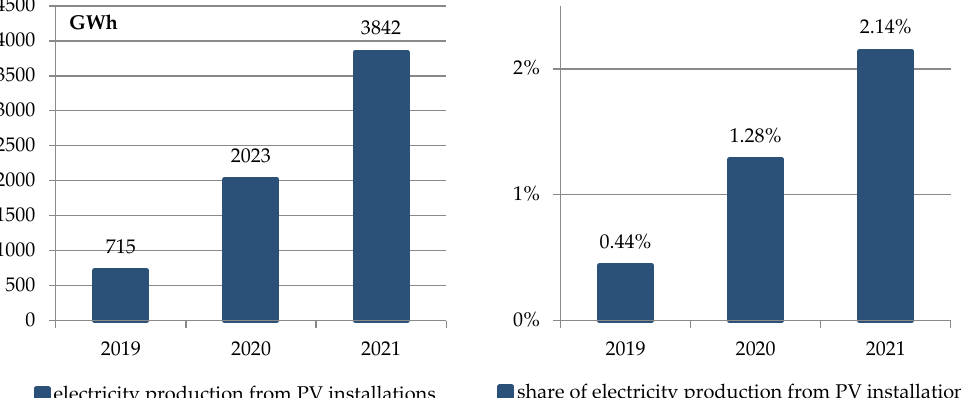
Figure 3. Production of electricity from PV installation and share of PV sources in electricity production in Poland in 2019–2021. Based on data from [79,80].